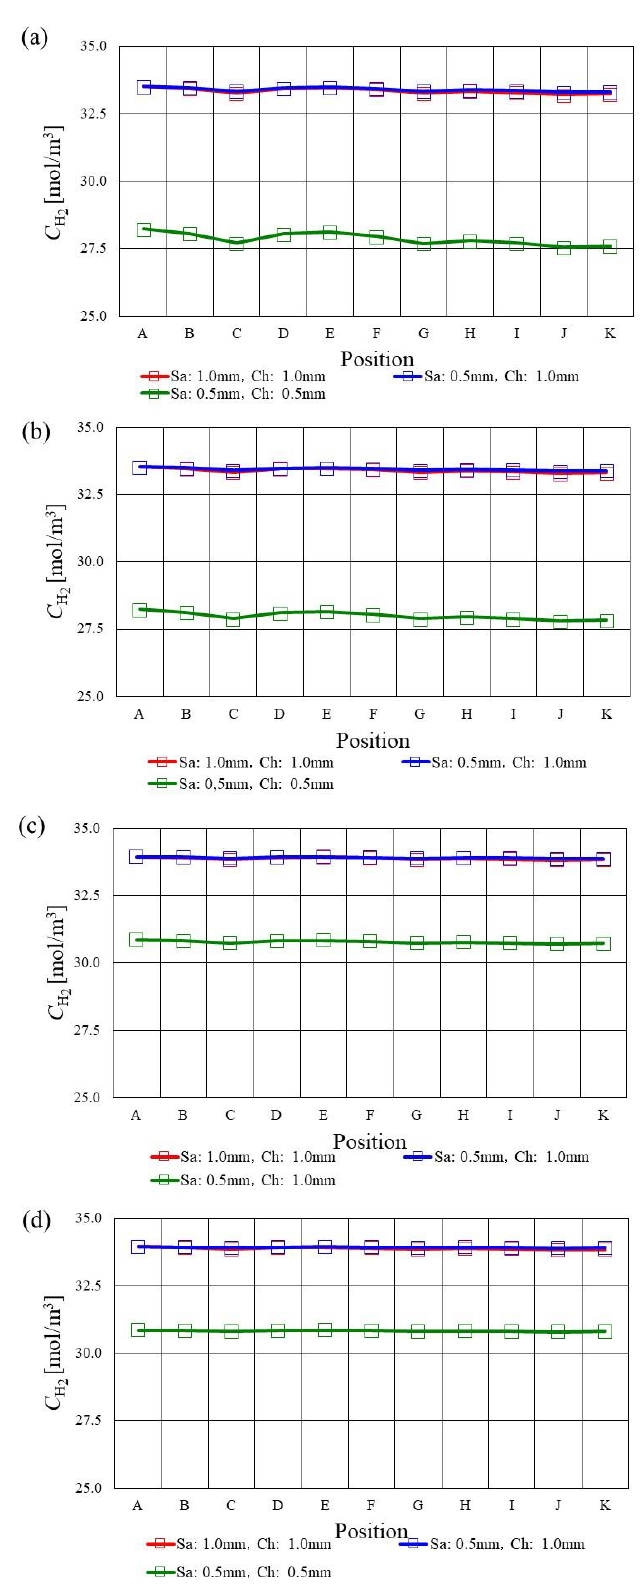
Figure 4. Molar concentration of H 2 along with the gas channel on the interface between PEM and catalyst layer at the anode among various s.t. at T ini = 373 K. ( a ) A80%RH/C80%RH, ( b ) A80%RH/C40%RH, ( c ) A40%RH/C80%RH, ( d )